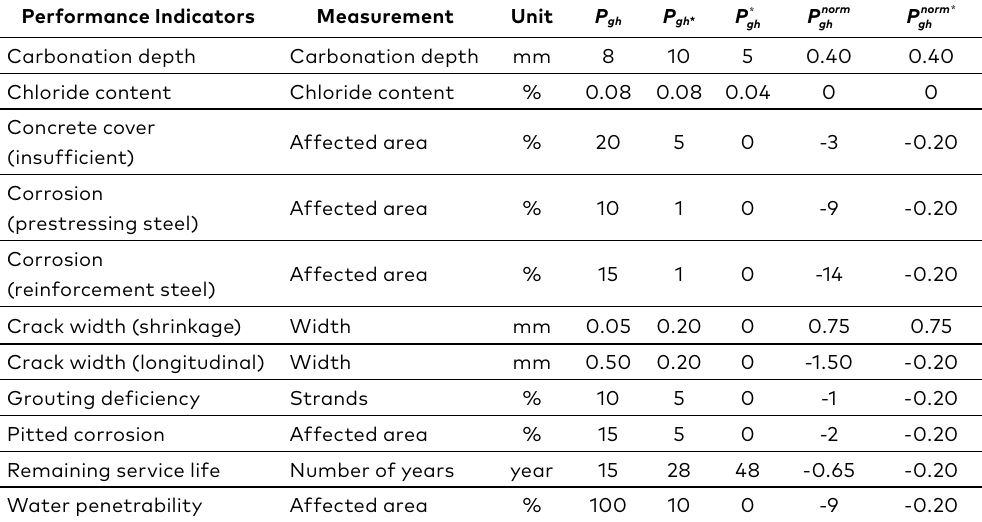
Table 3. All values of the Performance Indicators expressing Key Performance Indicators “Durability” about the superstructure of the Strimonas Bridge Performance